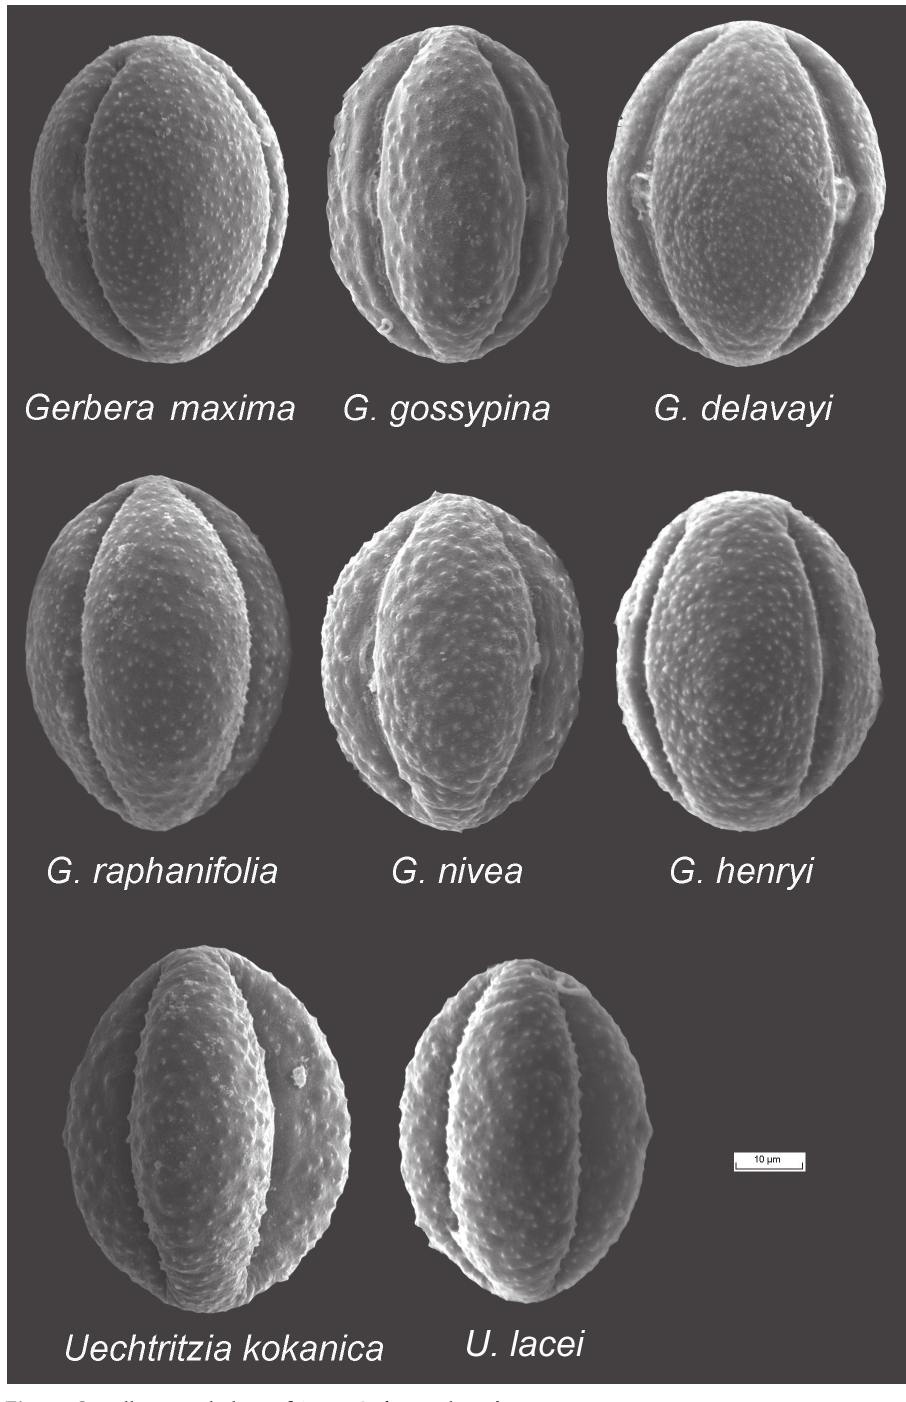
Figure 3. Pollen morphology of Asian Gerbera and Uechtritzia